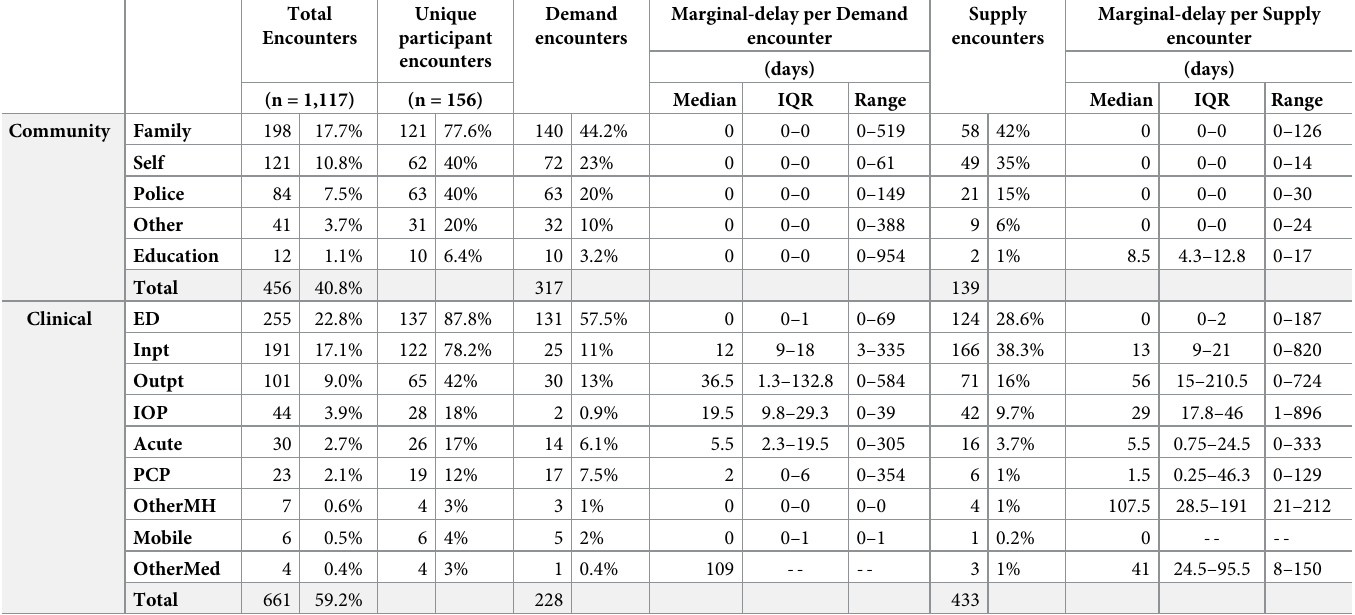
Table 4. Descriptive statistics of node type encounter frequency and marginal-delay